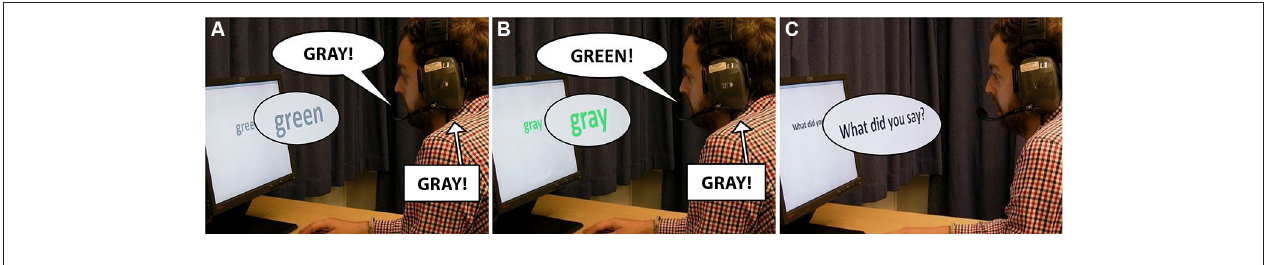
test, the participant’s feedback is manipulated by inserting the recording of “gray” as the participant utters the word “green”. (C) The participant is asked “what did you say?” directly following the